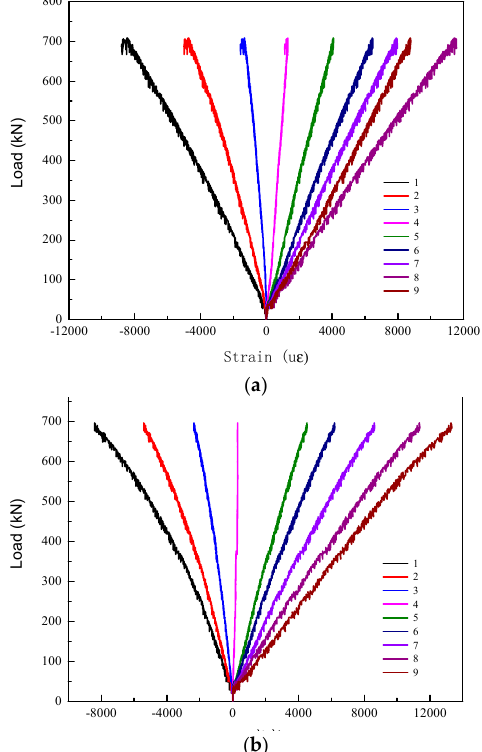
Figure 7. Load-strain curves of specimen series G2000-300-8. ( a ) Specimen G2000-300-8A ( b ) Specimen G2000-300-8B.